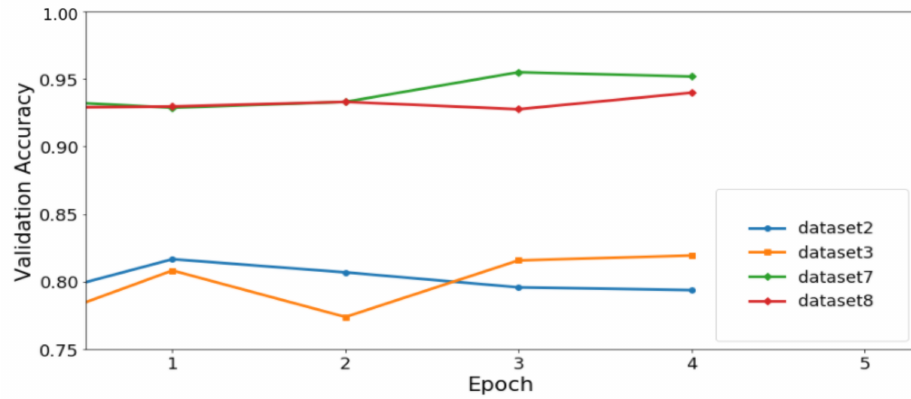
Figure 10. Validation